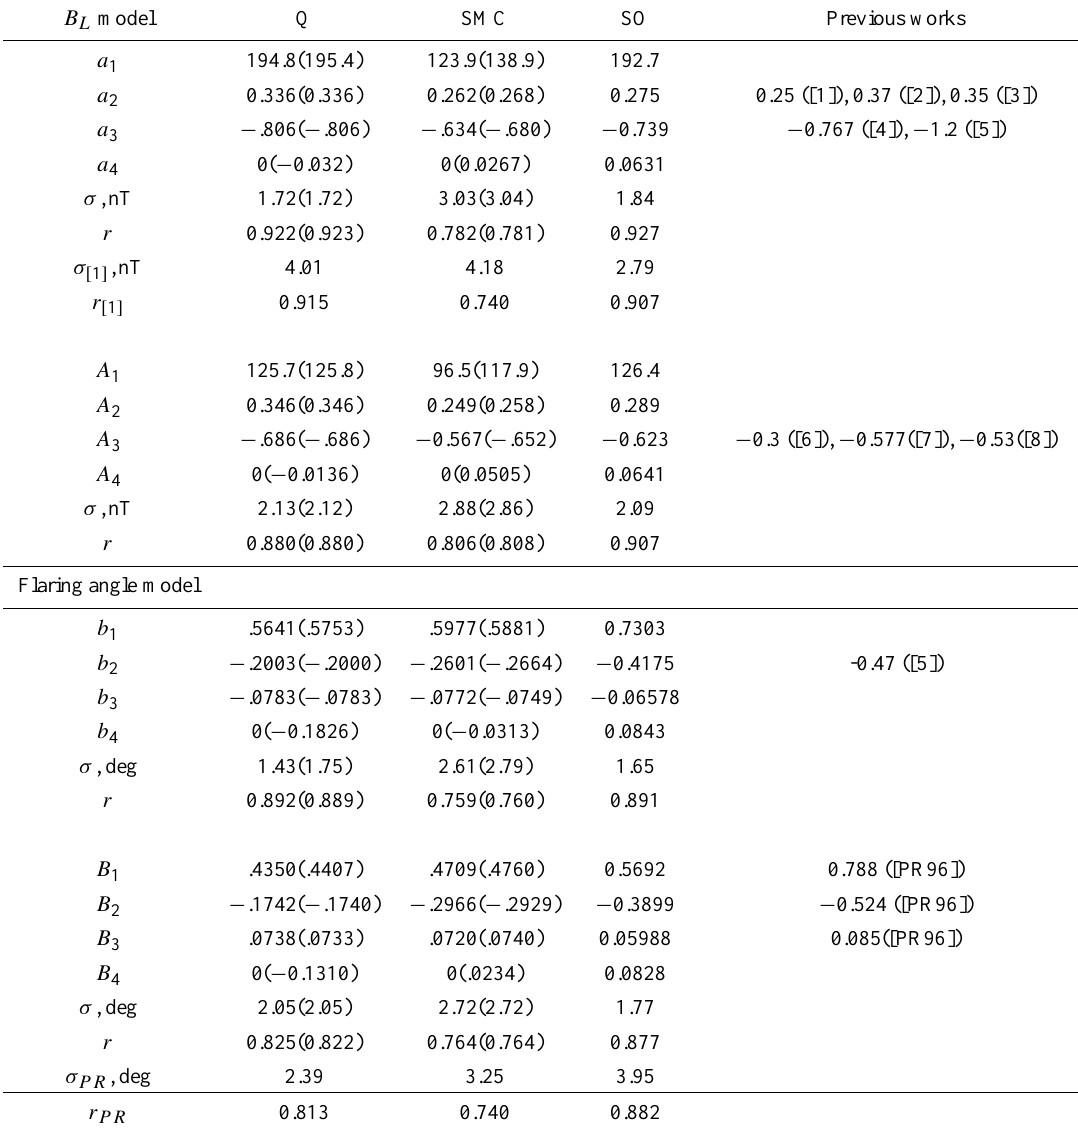
Table 3. Final (versus initial) regression